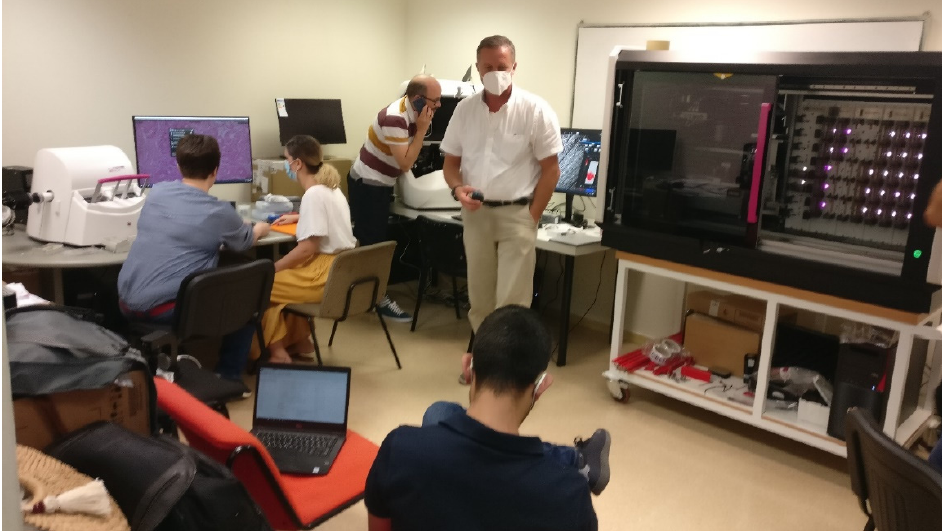
Figure 2. Testing room for test 1, showing the Palex 3DHISTECH team and equipment (PANNORAMIC SCAN II, PANNORAMIC 300 Flash DX, and PANNORAMIC 1000 Flash DX).